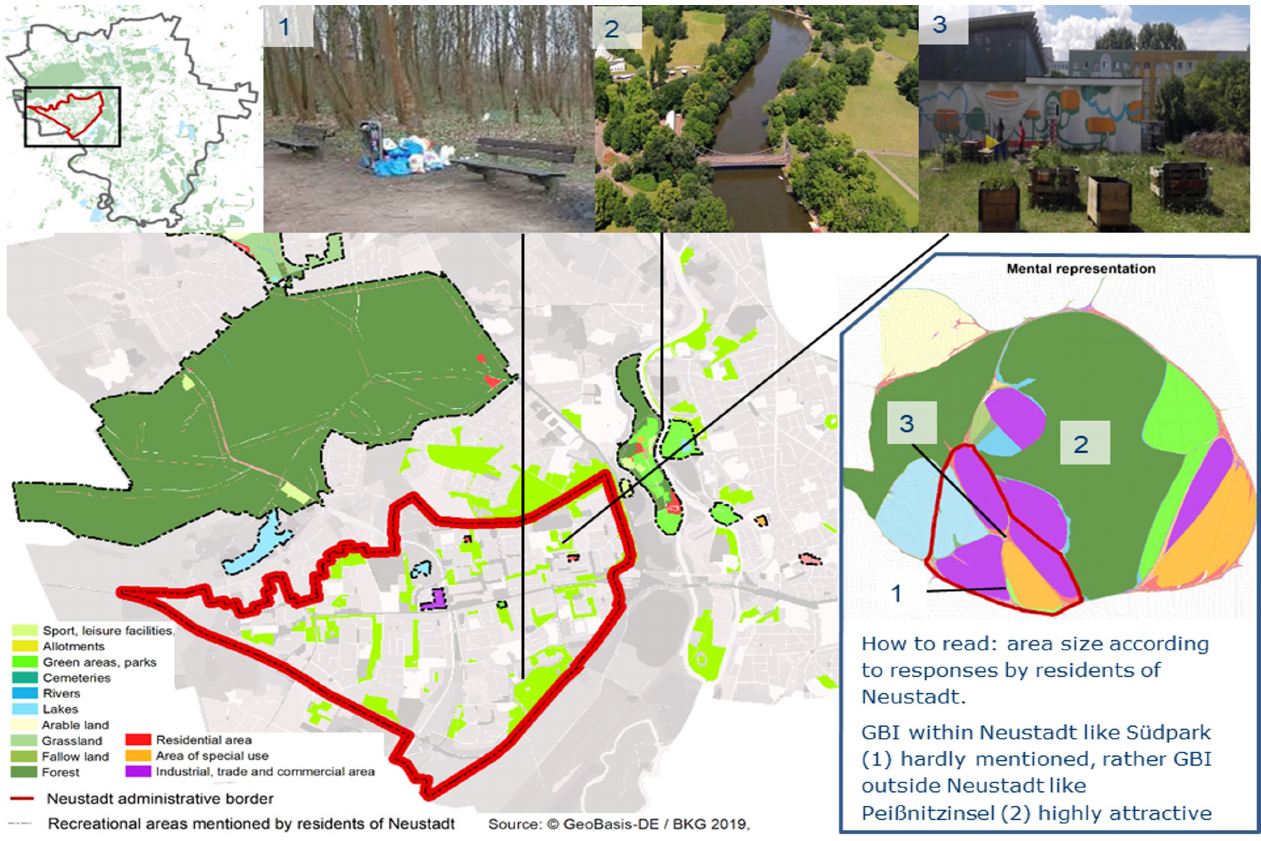
Fig. 2. The figure shows the GBI network of Halle, in particular of the central Saale floodplains (right part of the map and photo 2) and Halle Newtown (red bordered) in the west, including the Neutopia community garden with its planting boxes (photo 3). The map shows the real situation and distribution of the GBI network in both places, Saale floodplain and Halle Newtown, and the smaller map on the right shows the mental representation of the most important green spaces of the Halle Newtown residents as discussed in the text. All land uses were resized by the number of entries and provide a different picture: Halle Newtown and its GBI appears much smaller in this resized mental map compared with the Halle Saale-floodplains GBI—photo 1 from Halle Newtown GBI might explain